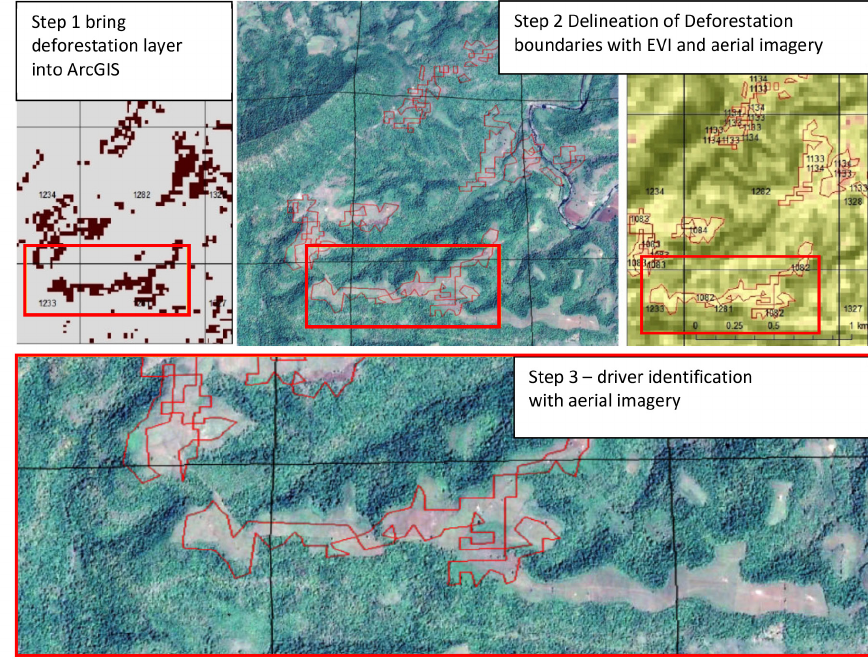
Figure 2. Decision steps for deforestation and forest degradation mapping associate with drivers